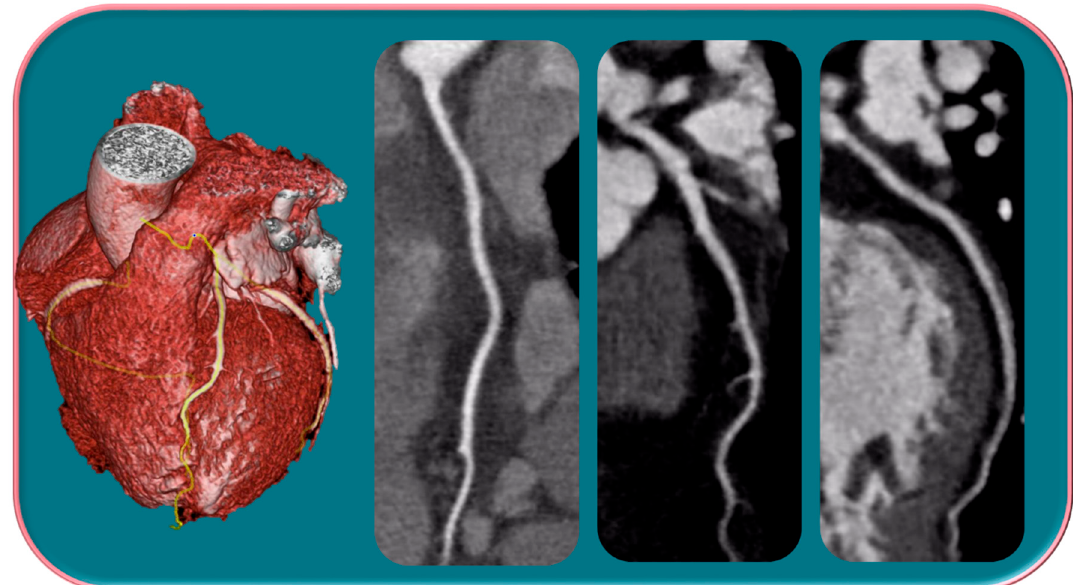
Figure 2. Female, 65-years-old, with typical angina, treated for hypertension and dyslipidemia. The patient was first categorized as intermediate-PPT risk of having CAD, for which CCTA was performed. The CCTA exam showed a regular coronary tree. Different trials have demonstrated that women show more frequent anginal symptoms than men, often with a higher risk profile, although a lower overall burden of CAD, a higher prevalence of NOCAD, and a frequent insufficient ischemia have been highlighted.